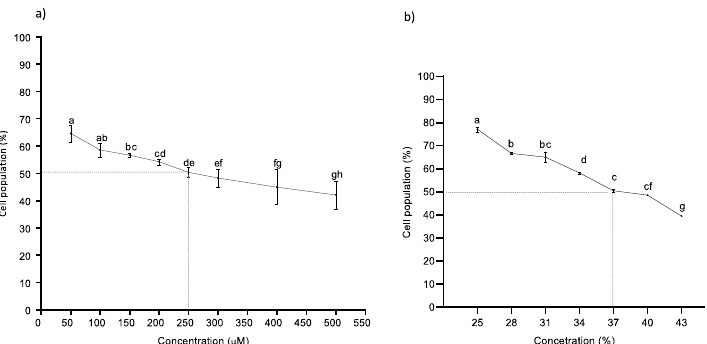
Figure 2. Cell viability of HT-29 cells after treatment with naringenin or FEN. The effect of ( a ) naringenin (50–500 µM) and of ( b ) FEN (25–43%) was evaluated on HT-29 cells after 24 h post incubation (MTT assay). Viability is expressed as a percentage of cellular activity between the exposed group to naringenin ( a ) and FEN ( b ). The experimental data are expressed as the mean value ± SD of the three independent experiments with three replicates each one. Letters indicate statistical difference ( p < 0.05).